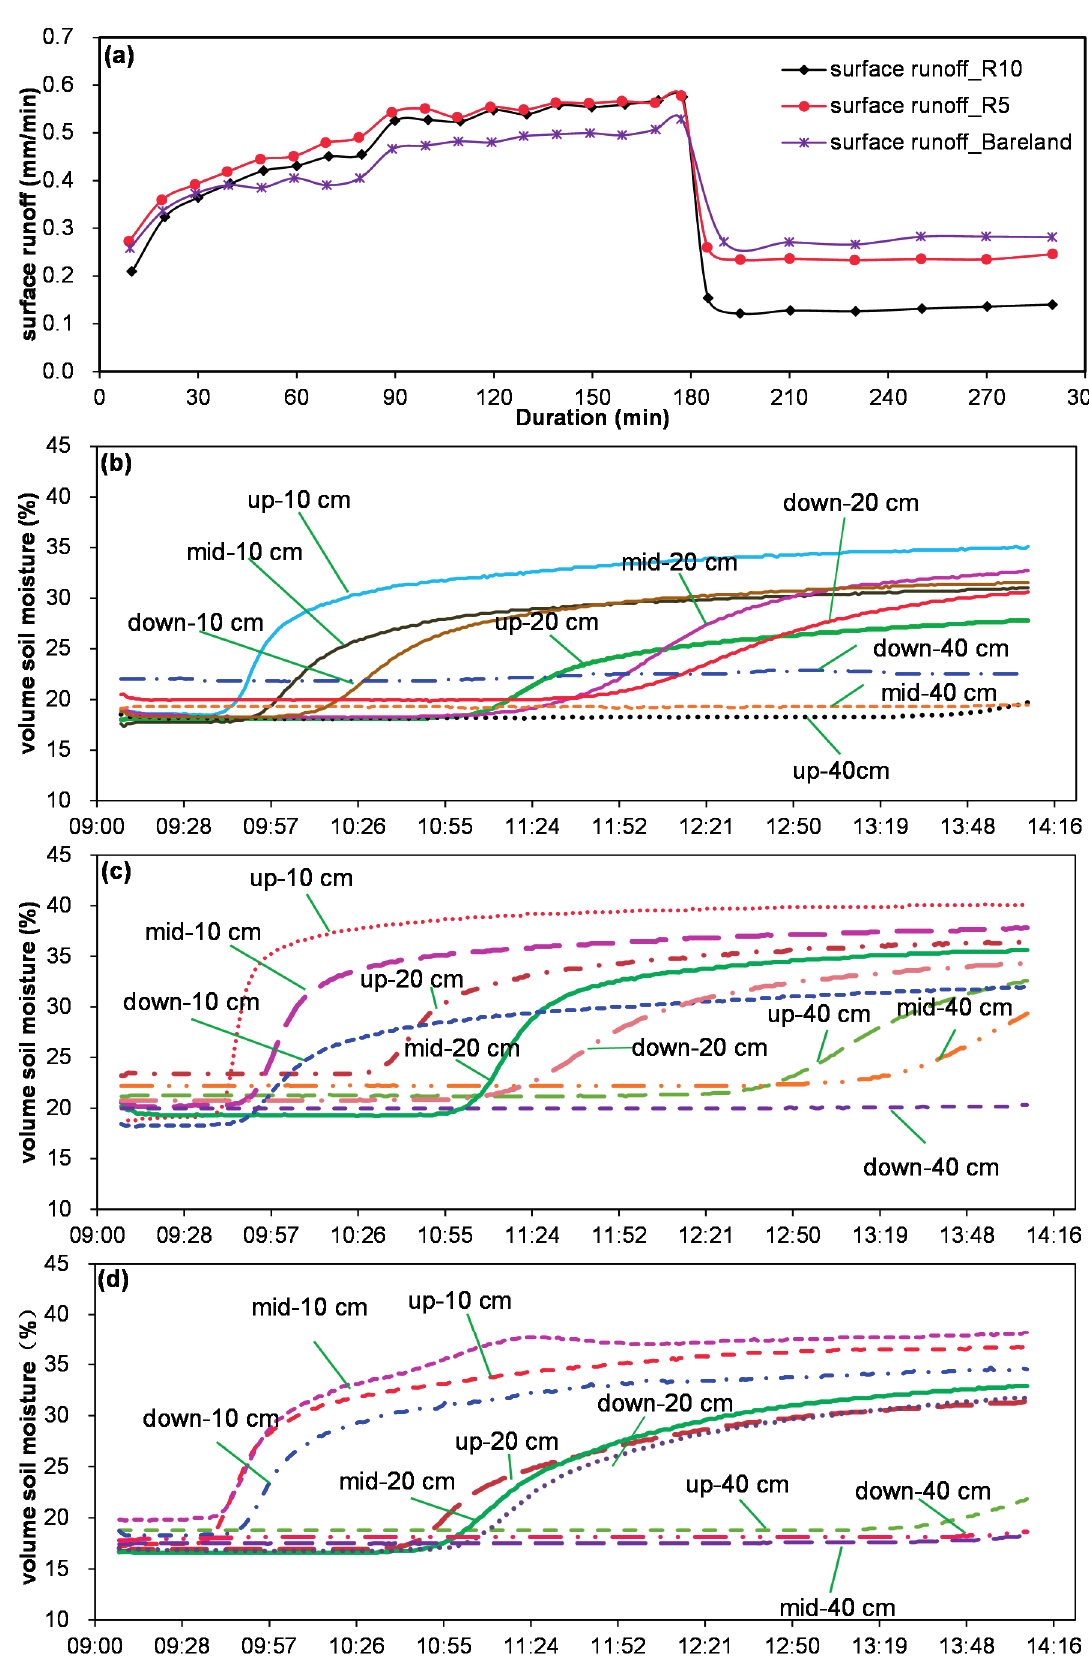
Figure 5. Rainfall-runoff process ( a ) and soil moisture dynamics at different slope depths and positions for ( b ) R5 plot, ( c ) R10 plot and ( d ) bare land during the P2 rainfall